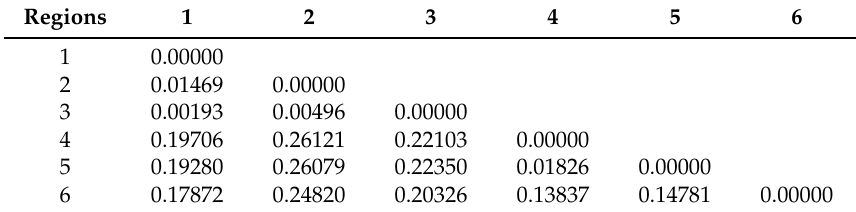
Table 4. Pair-wise F ST values among the six sampling locations of A. conjugella in Southern Norway. Regions 1 2 3 4 5 6 1 0.00000 2 0.01469 0.00000 3 0.00193 0.00496 0.00000 0.19706 0.26121